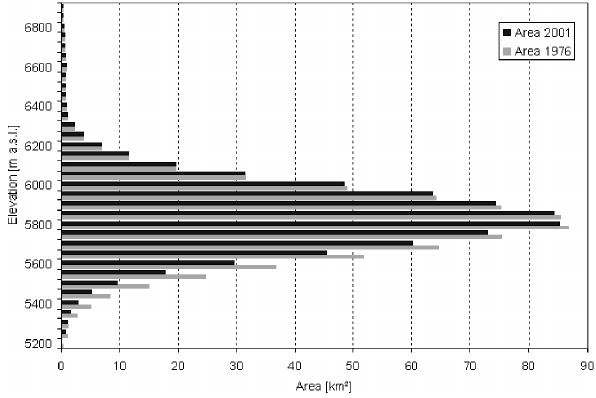
Fig. 8. Changes in glacier hypsometry 1976–2001; each bar repre- sents an elevation interval of 50m.